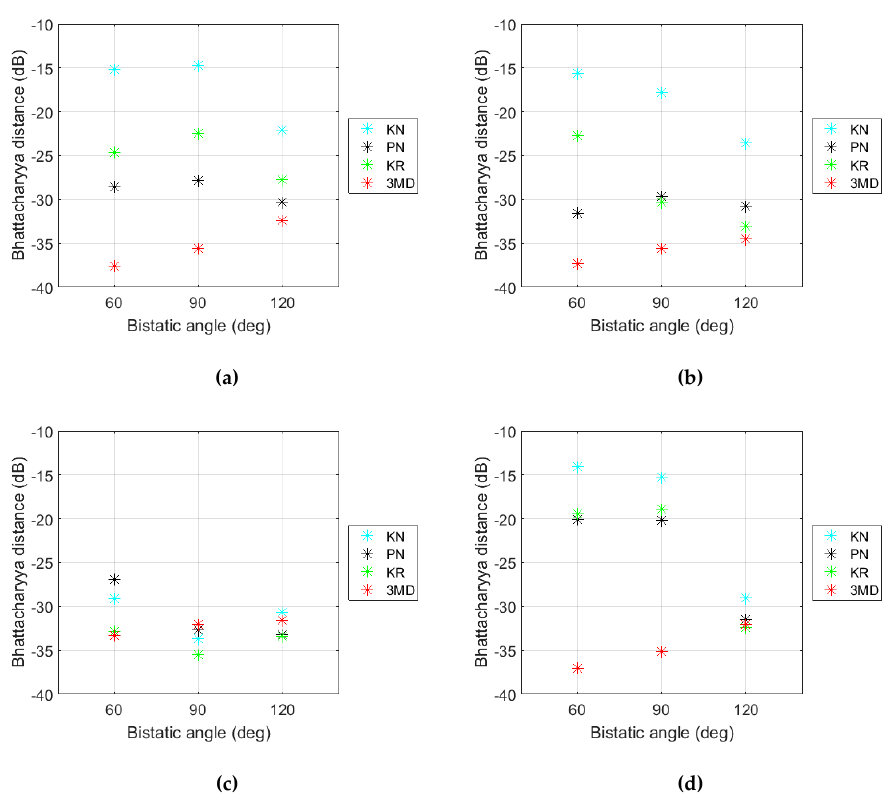
Figure 10. NetRAD S-band: Bhattacharyya distance (in dBs) for the NetRAD data. ( a ) HH polarization, monostatic, ( b ) HH polarization, bistatic, ( c ) VV polarization, monostatic, ( d ) VV polarization, bistatic.